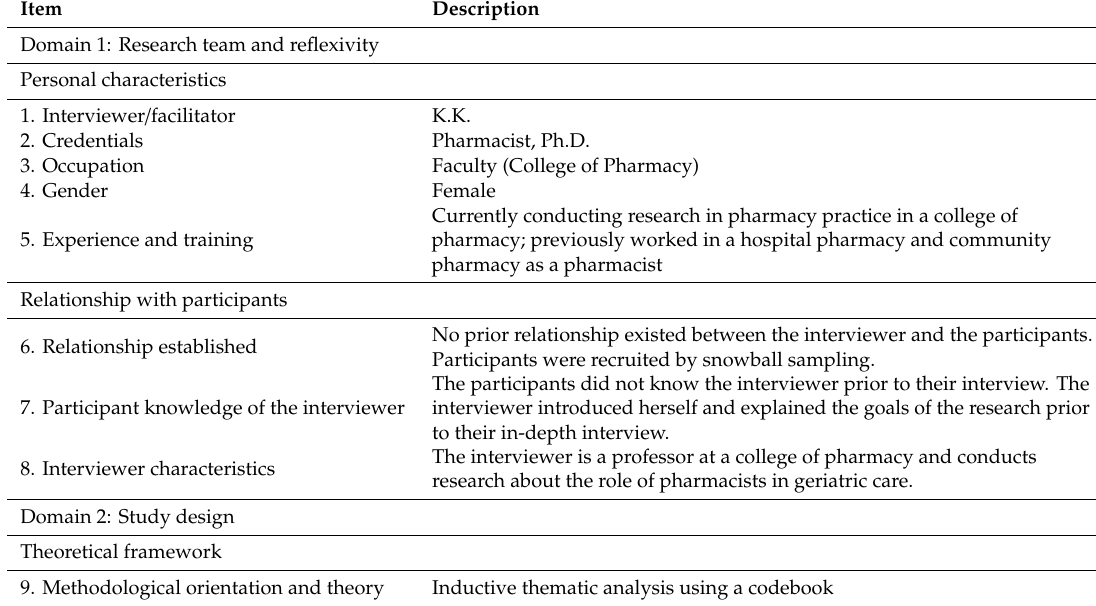
Table A1. Description of Study Methodology Using Consolidated Criteria for Reporting Qualitative Studies (Based on COREQ-32